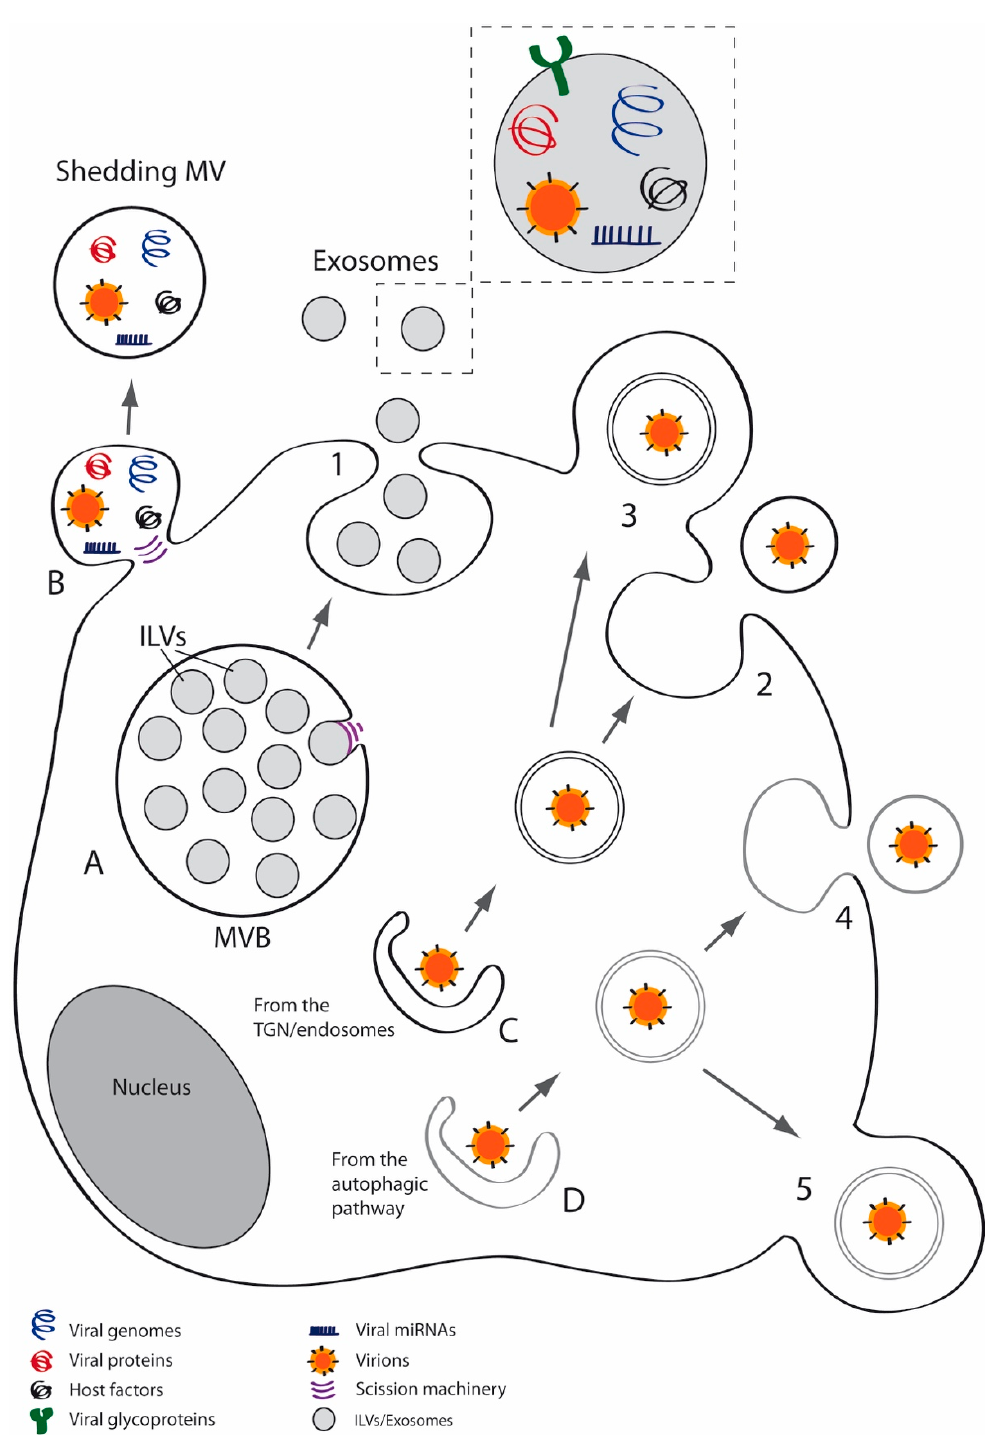
Figure 1. Schematic models of viral spread via extracellular vesicles (EVs). The EV-mediated release of virions, viral components and induced/altered host factors by infected cells, may be performed using different pathways and molecular machineries. Several viral components such as DNAs, RNAs, miRNAs, and/or proteins, may be packaged into EVs. Infected cells may also release EVs containing host factors such as DNAs, RNAs, miRNAs and/ or proteins, induced or altered by the infection. All these components may trigger both pro- or anti-viral effects. A. Viruses may use the multivesicular bodies (MVBs) for viral spread, packaging virions or viral factors into intraluminal vesicles (ILVs) that will be released to the extracellular medium (exosomes) after fusion of the MVB with the plasma membrane (1). B. Viruses may also exit cells enclosed in shedding microvesicles (MVs), which might also contain viral and/or host factors. Other feasible routes for viral spread involve the secretory (C)